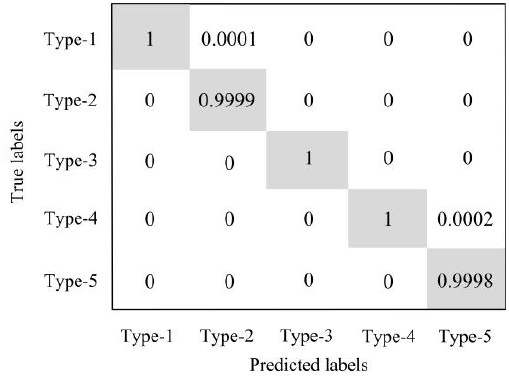
Figure 19. Confusion matrix of the gear dataset.